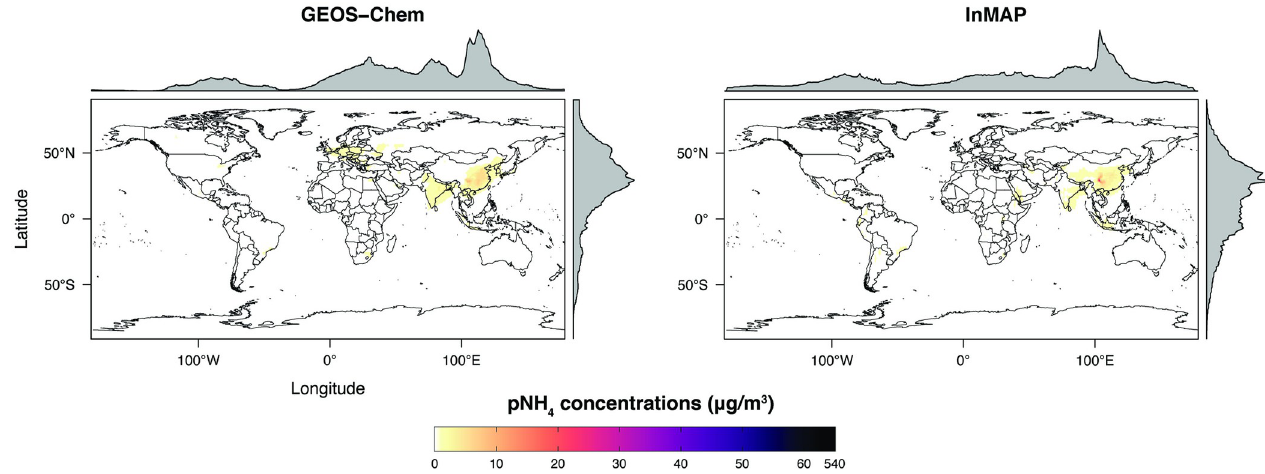
Fig 5. Global InMAP and GEOS-Chem annual-average ground-level pNH 4 concentrations.